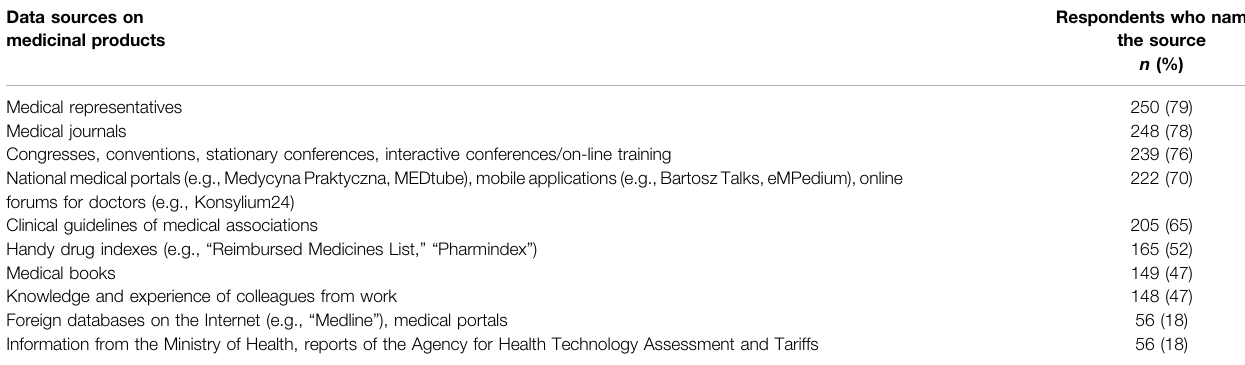
TABLE 1 | Sources of information on medicinal products used by responding physicians in the last 6 months ( N (cid:1) 316). Data sources on medicinal products